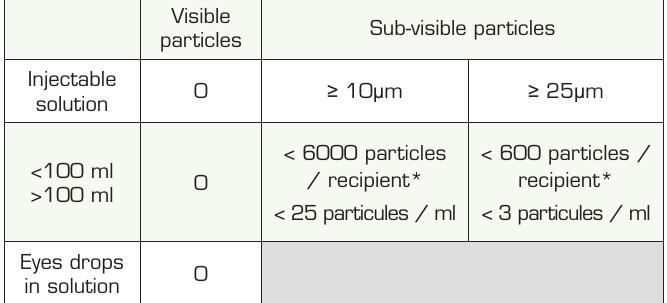
Table 6: Limits in visible and sub-visible particles of preparations in the form of